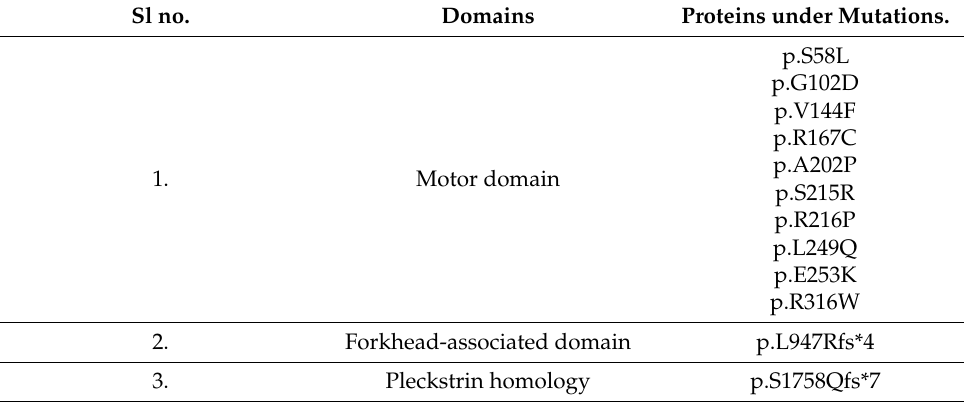
Table 2. Various parts of the KIF1A protein susceptible to mutation [26–29]. Sl no. Domains Proteins under